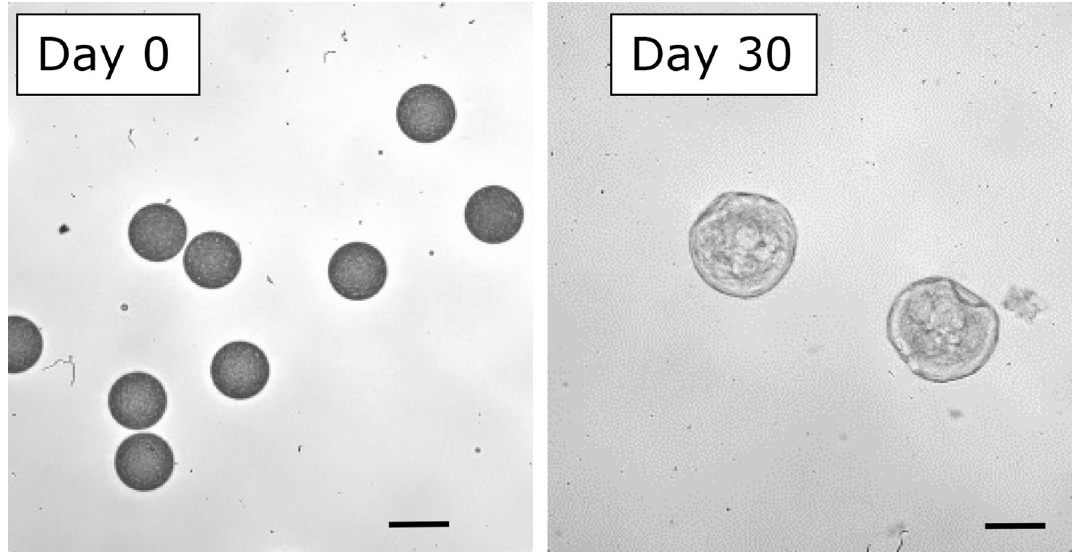
Figure 6. Microparticle morphological changes over time. Images taken at ×40 magnification comparing size and morphology of original 44 µm microparticles on day 0 and swollen microparticles (79 µm) on day 30. Scale bar is 44 µm.